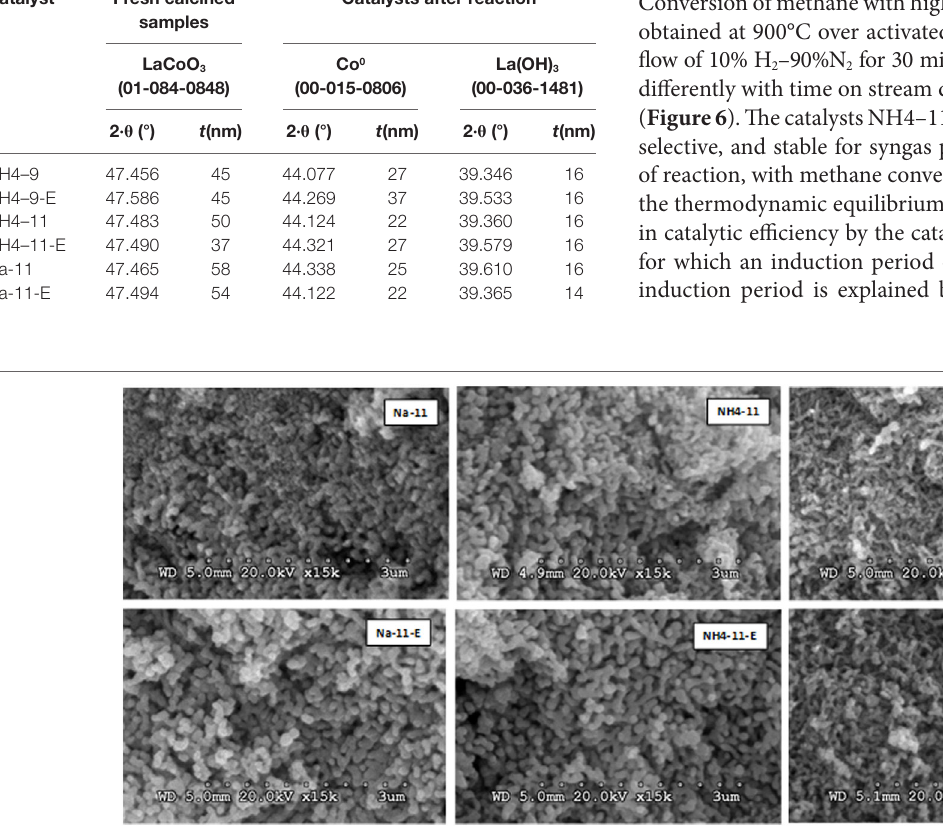
Table 2 | Average domain size of LaCoO 3 for fresh calcined samples and for catalysts after reaction. catalyst Fresh calcined